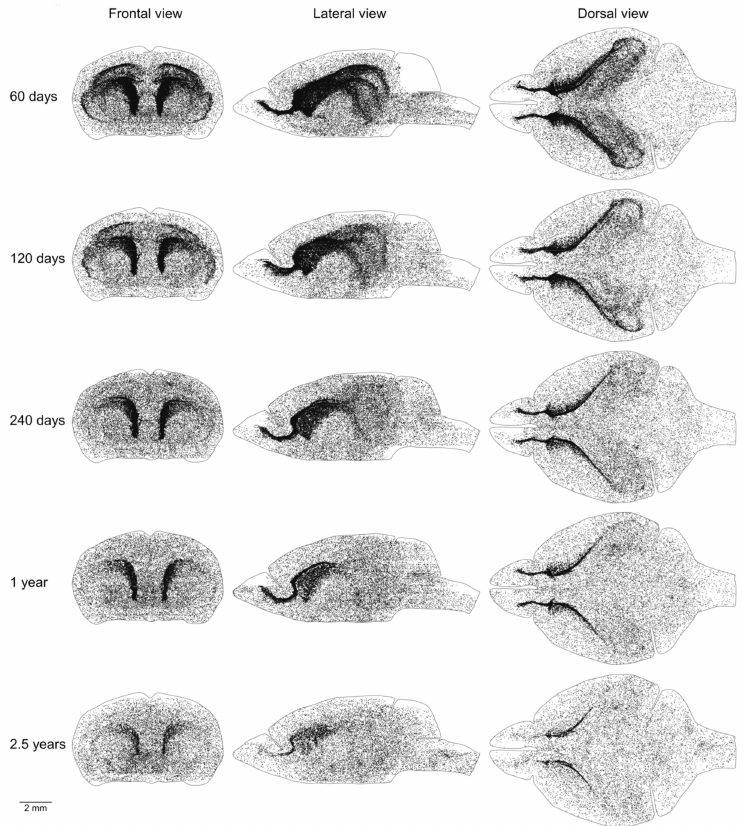
Figure 2. Distribution of proliferating cells in the mouse brain. Each 5-Ethynyl-2 (cid:48) -deoxyuridine (EdU)-labeled nucleus is shown as a black dot. The scale is shown at the bottom. The brain shape is outlined with a black line. Frontal, lateral, and dorsal views of the brain are shown. Mouse age is shown on the